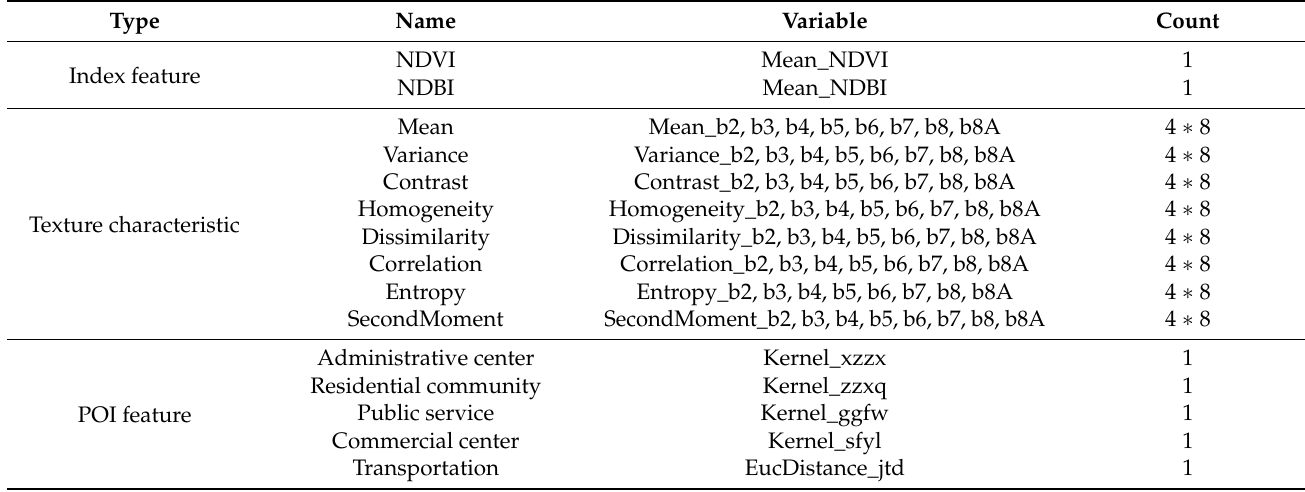
Table 4. Features extracted from Sentinel-2 and POI data.